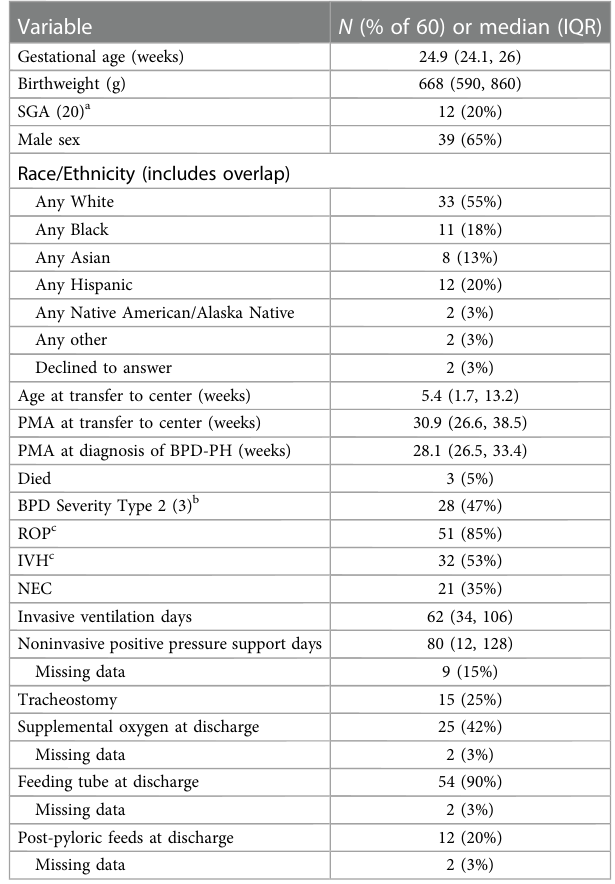
TABLE 1 Demographic and clinical characteristics of patients with bronchopulmonary dysplasia-pulmonary hypertension (BPD-PH) ( n